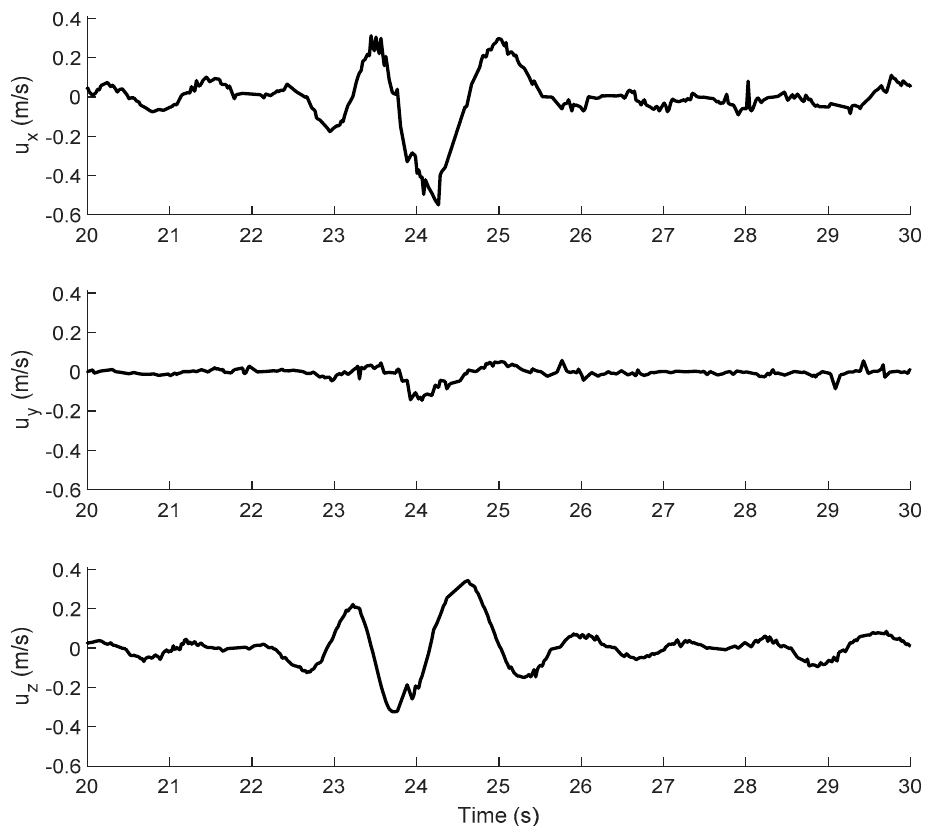
Figure 6. Velocity components measured by the Acoustic Doppler Velocimetry (ADV) located at x = 7 m and 23.5 cm below the mean water level (1.5 m). The U x , U y , and U z , are velocity components in the horizontal along the tank, in the horizontal across the tank, and in the vertical, respectively. Note the high velocities after the occurrence of the plunging breaker at t = 23 s.